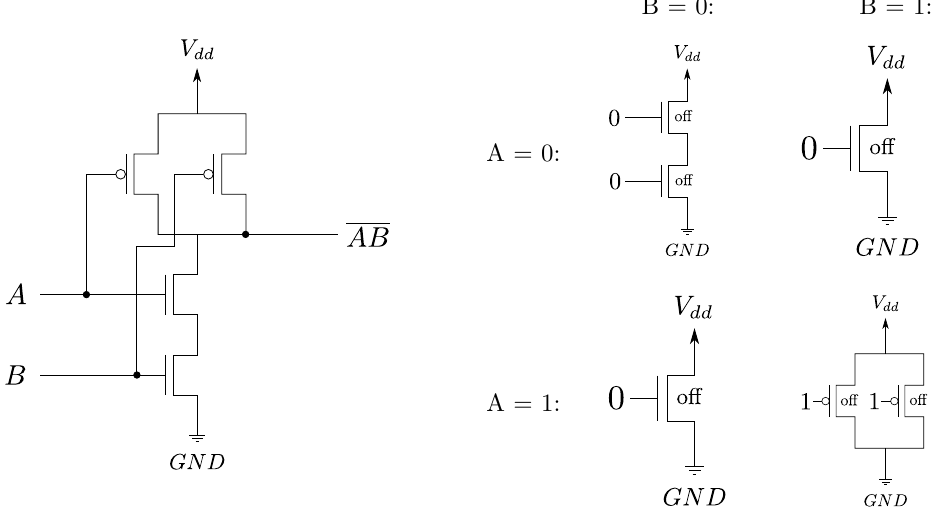
Figure 3: CMOS NAND gate (left) and formation of inactive transistors across the power supply path for different inputs (right), assuming perfect conduction for active